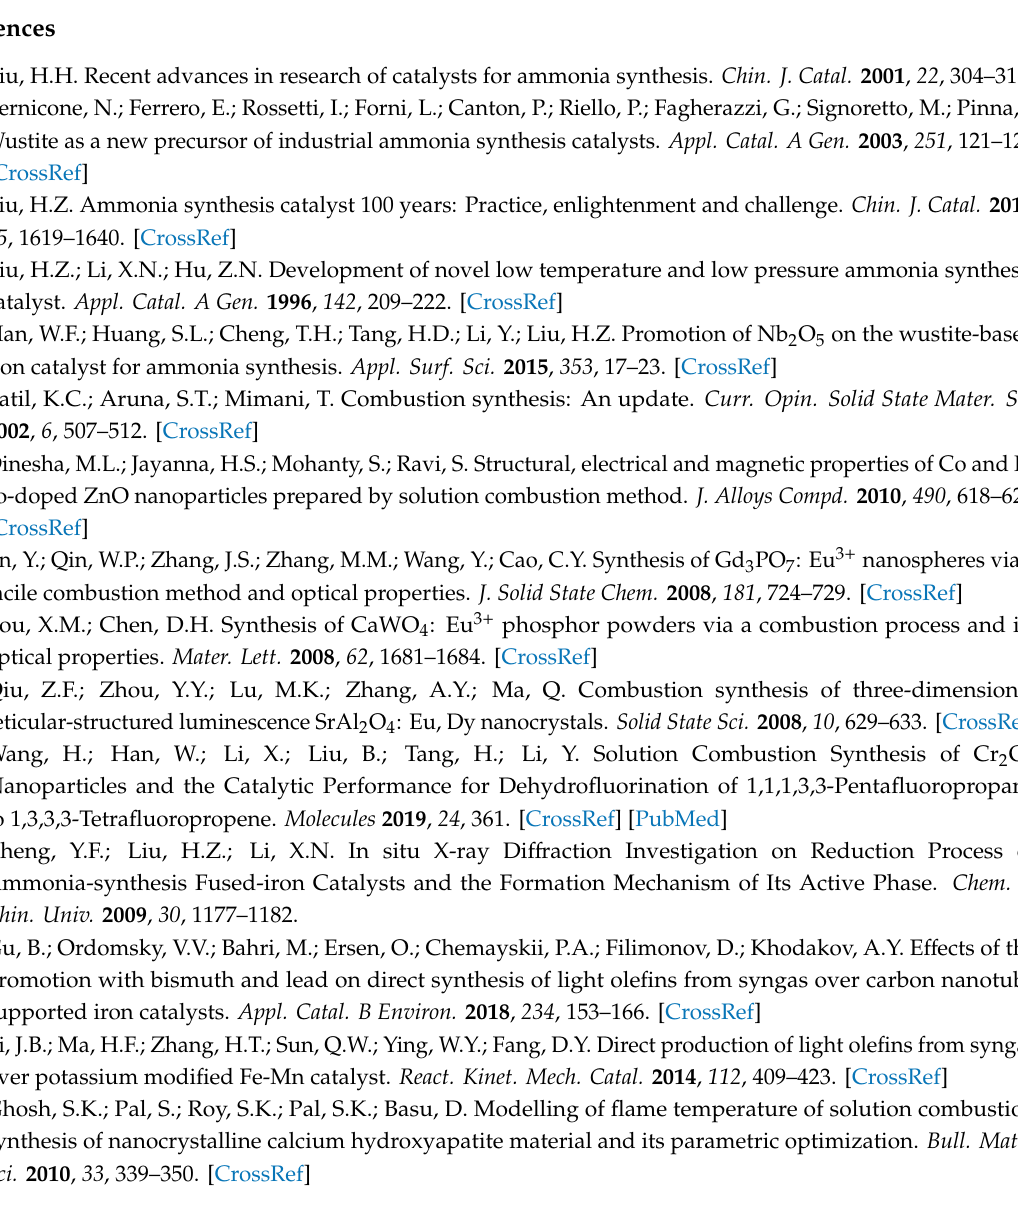
Table S1: Nomenclature of catalysts. Figure S1: Reaction rate of ammonia synthesis over citric acid / Fe composite catalysts prepared by SCS at a reaction condition. All the catalysts were reduced by temperature programmed reduction. Figure S2: Reaction rate of ammonia synthesis over glycol / Fe composite catalysts prepared by SCS at a reaction condition. All the catalysts were reduced by temperature programmed reduction. Figure S3: Reaction rate of ammonia synthesis over urea / Fe composite catalysts prepared by SCS at a reaction condition. All the catalysts were reduced by temperature programmed